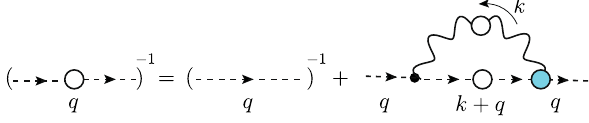
Fig. 7 The SDE for the ghost propagator. The white circles represent the full gluon and ghost propagators, while the blue one denotes the full ghost-gluon